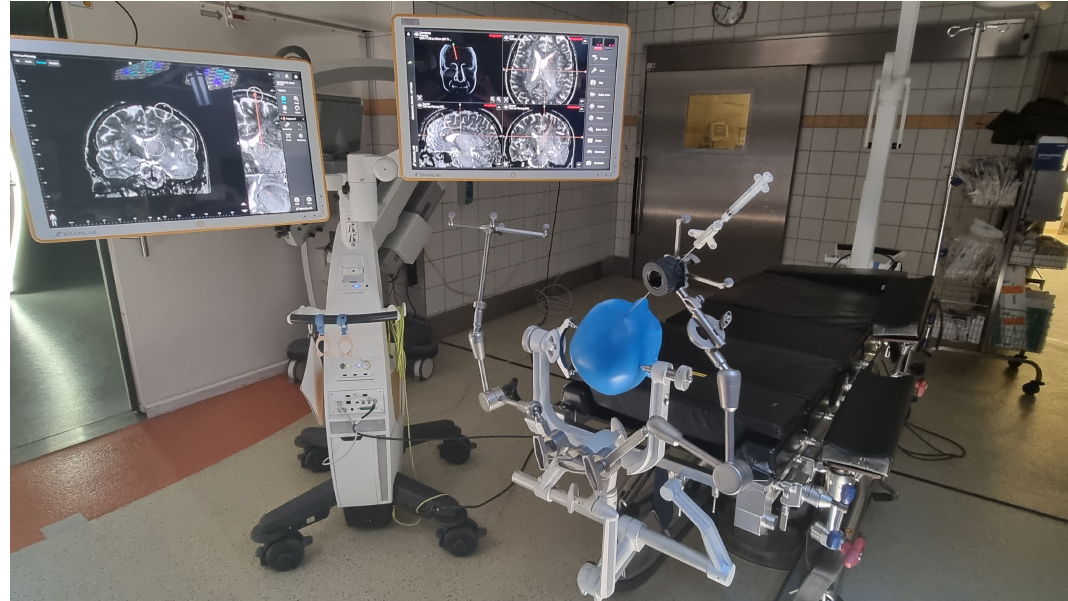
Figure 1. VarioGuide intraoperative setting a.